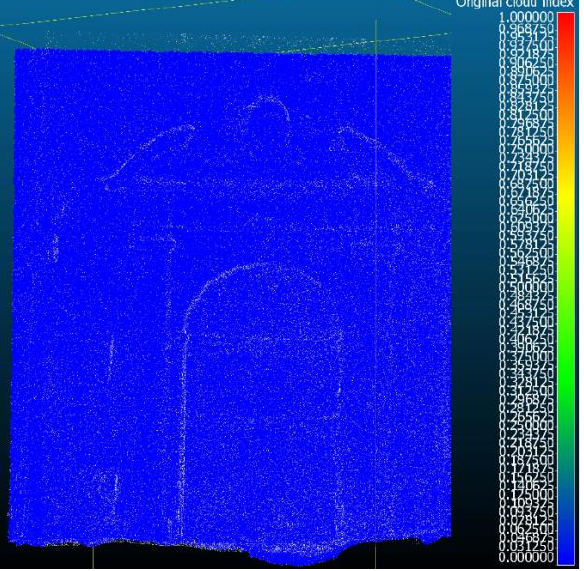
Figure 12: Merge cloud of Low-Image data set dense cloud and ground truth dense cloud. The white colour indicates a major RMS value than blue one.